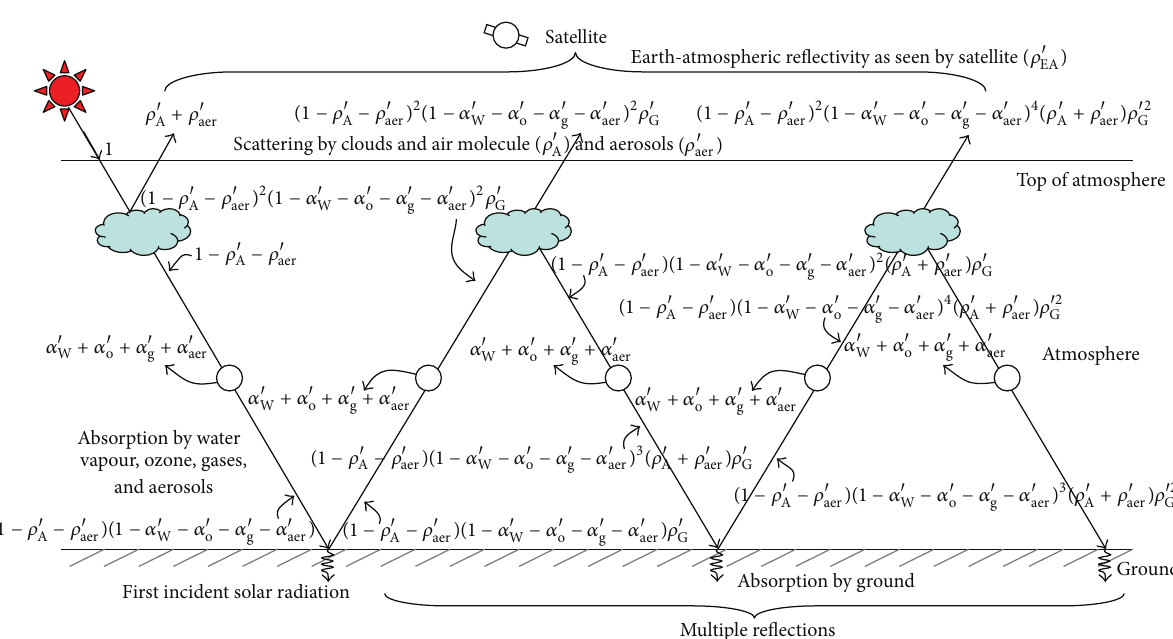
Figure 1: Schematic diagram of the radiation budget as seen by the satellite in the improved model.